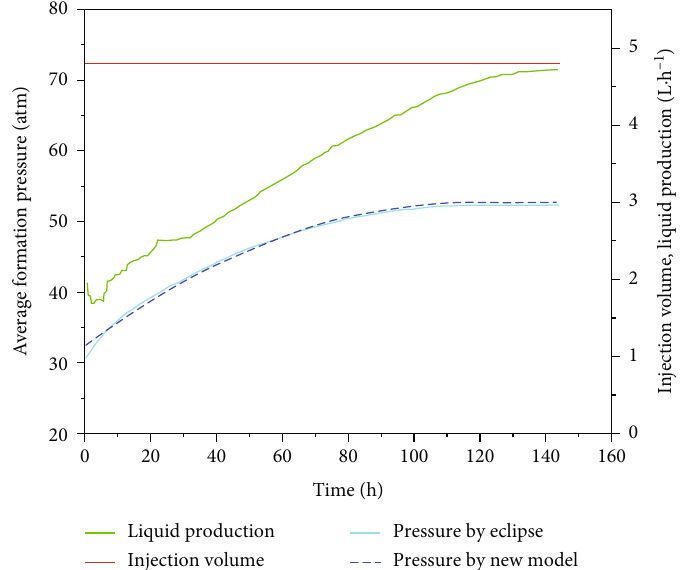
Figure 7: Relation of the injection-production and reservoir pressure calculated by di ff erent models.